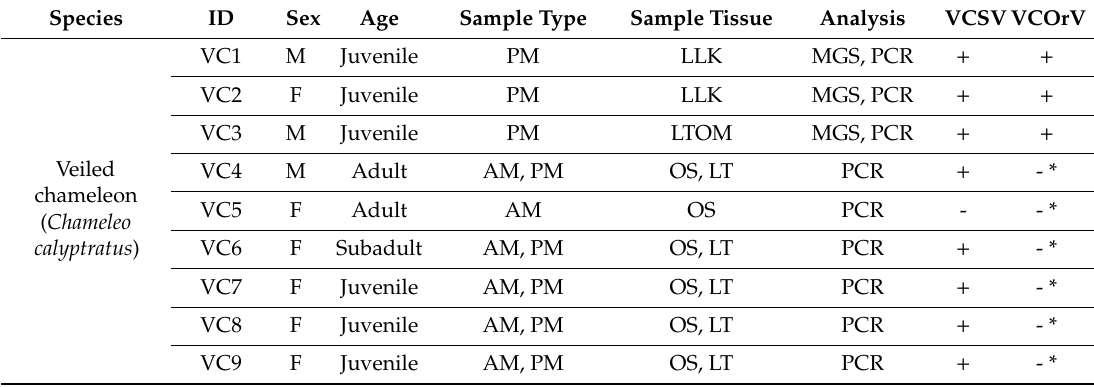
chain reaction. NT, not tested. * Undetected by the methods described but cannot confirm negative